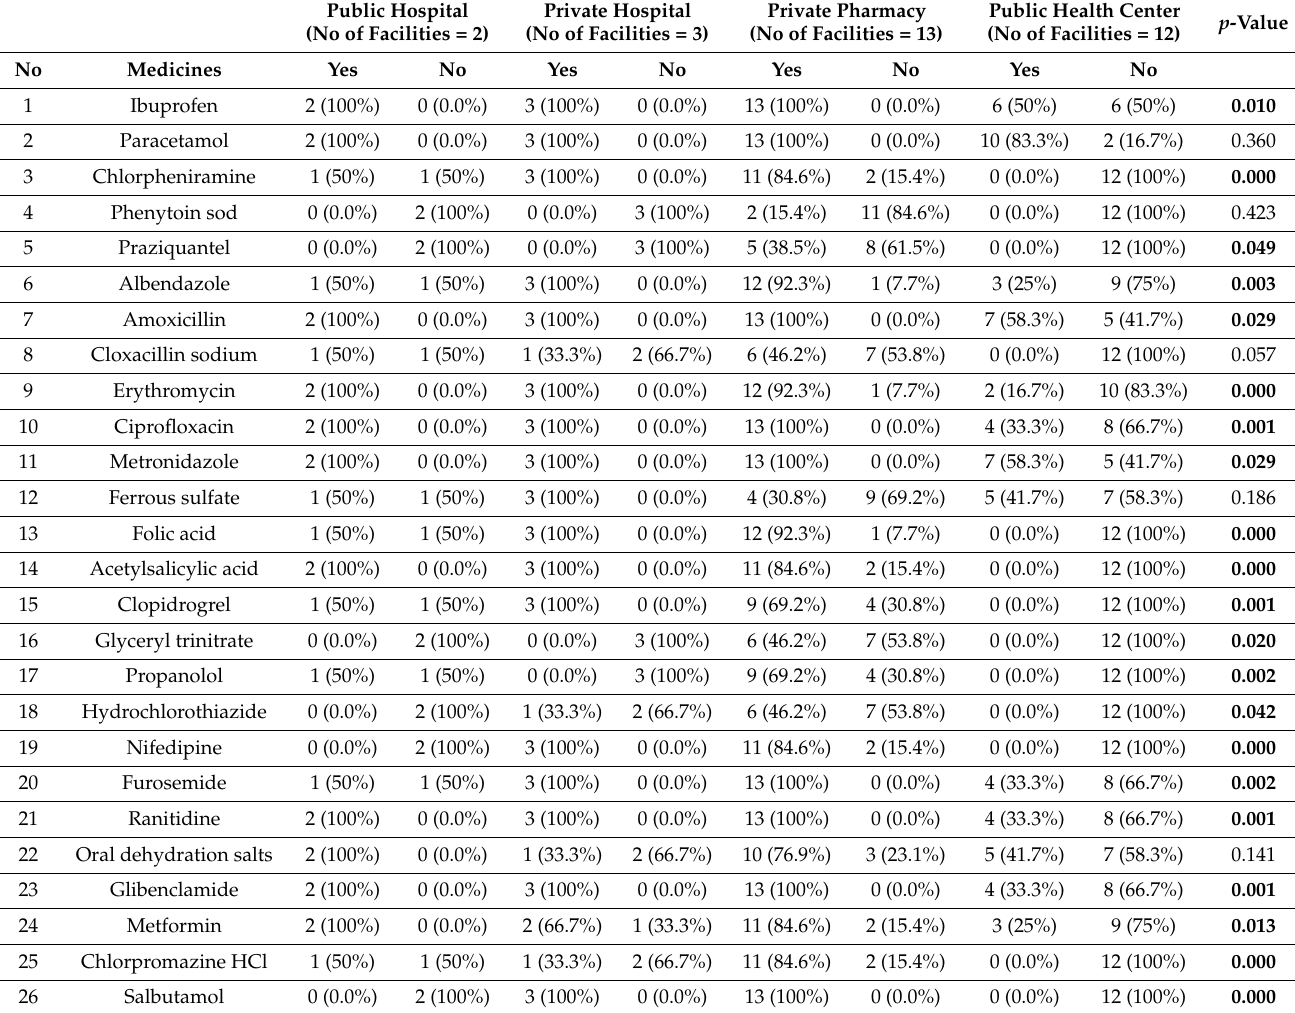
Table 5. Availability of essential medicines surveyed in the different health